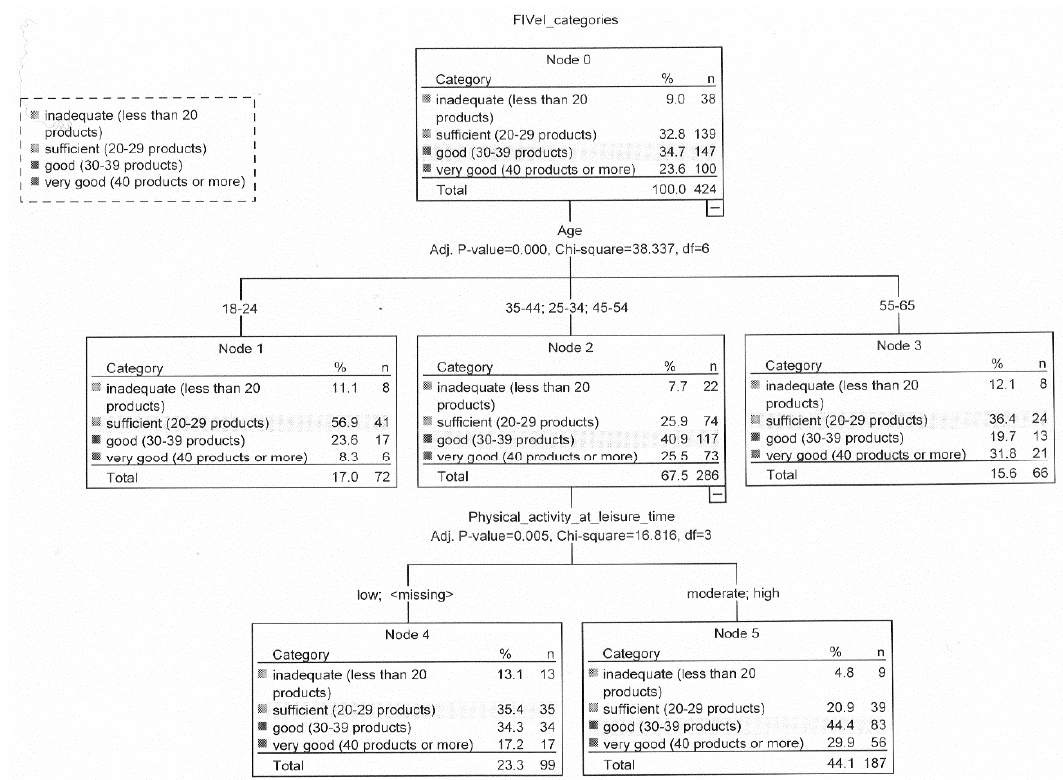
Figure 4. Relationship between food intake variety, eating addiction, selected lifestyles variables, and sociodemographic characteristics in the group with normal body